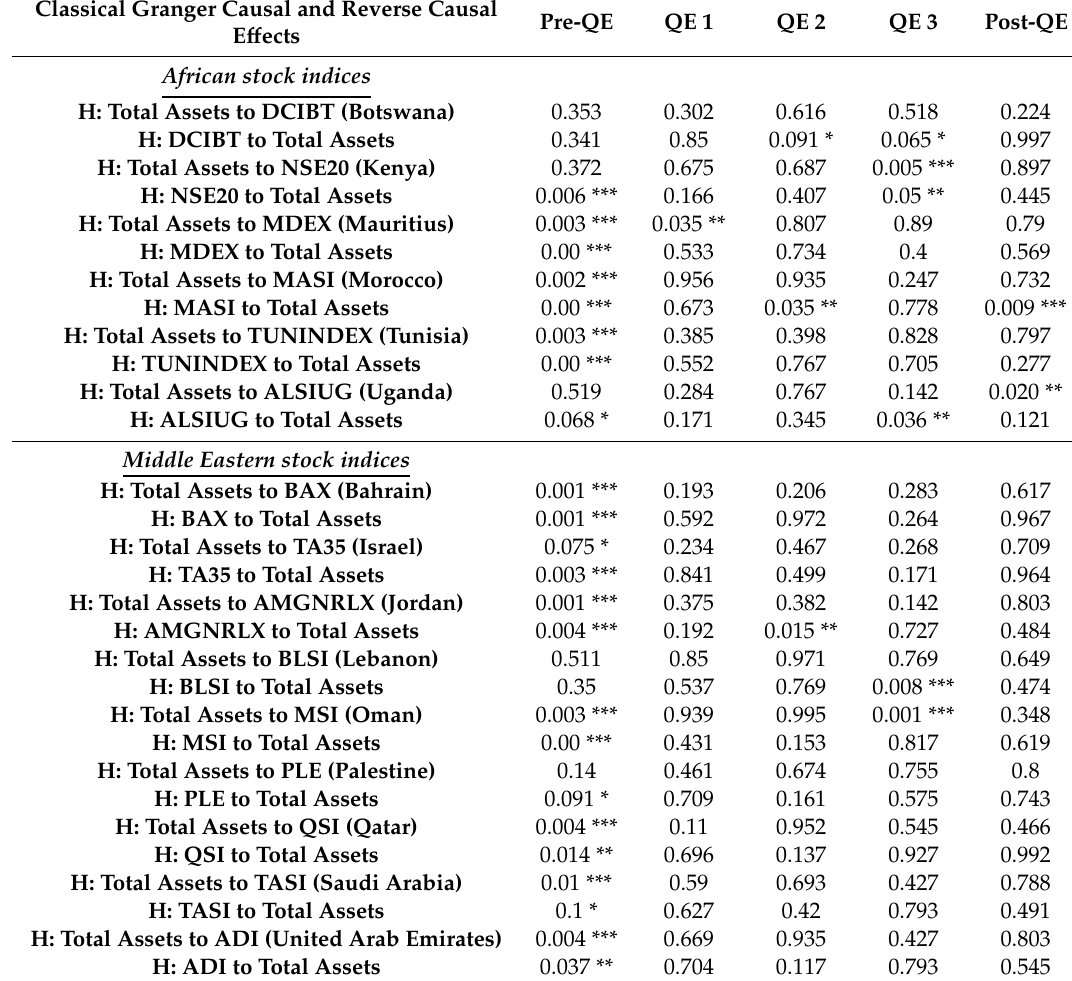
Table 6. Classical Granger causality test